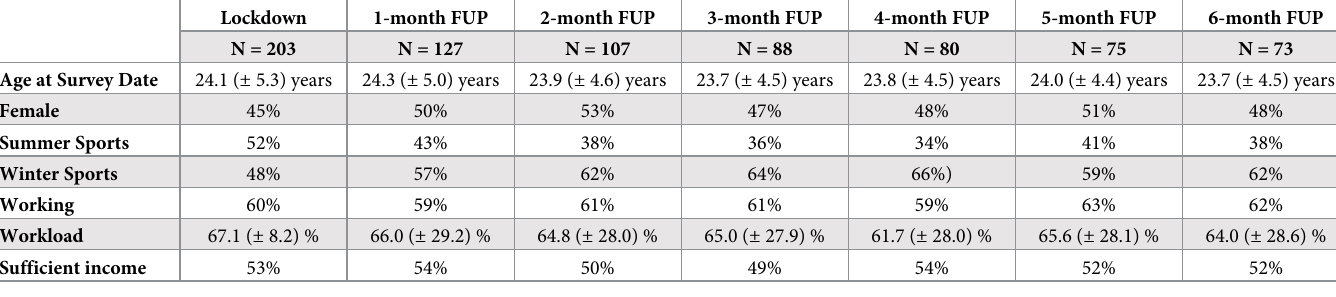
Table 1. Summary table of demographic data at different time